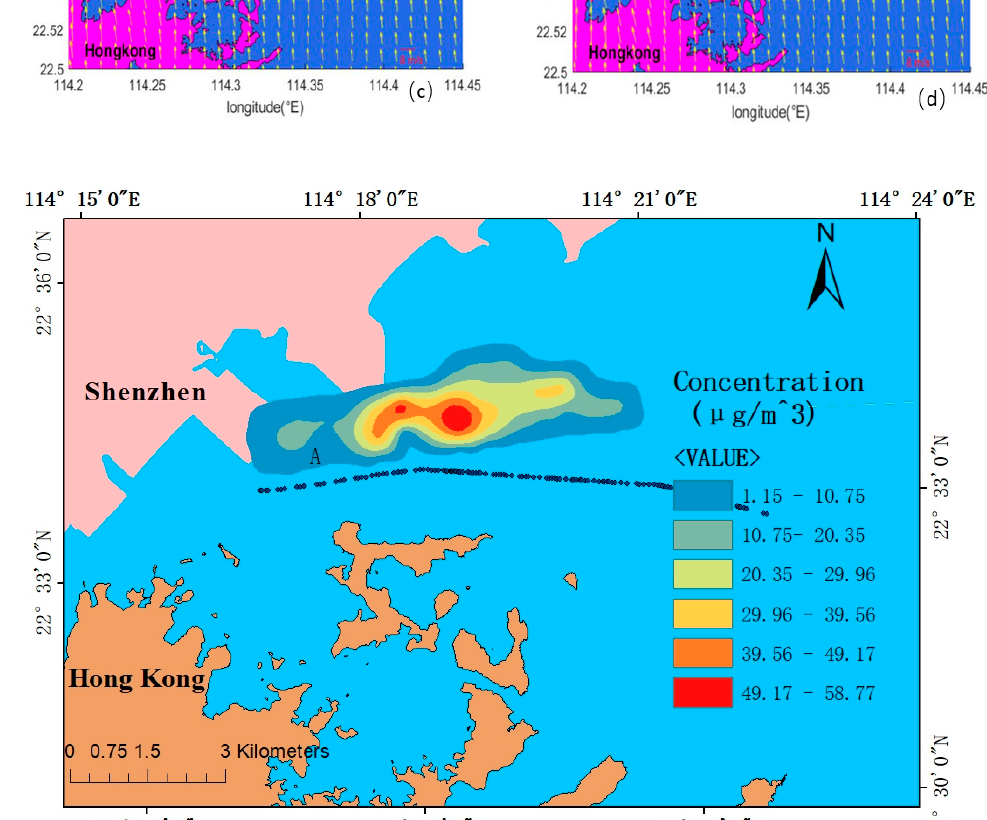
Figure A3. Wind field at different heights at the departure stage of Vessel F and the spatial distribution of the maximum concentration of each simulation grid during the simulation period. ( a ) 10m, ( b ) 30m, ( c ) 60m and ( d ) 120m.